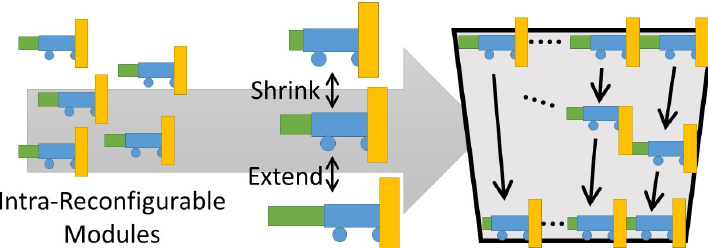
Figure 3. Nested reconfiguration for the glass façade cleaning robot. Extension and contraction of individual modules helps adapting to window shapes with different shapes (intra-reconfigurability). The robot system adapts to various window shapes by varying the number of intra-reconfigurable modules deployed (inter-reconfigurability). The arrows in the right figure and the dotted lines represent the movement flow and linkages of the modules, respectively.